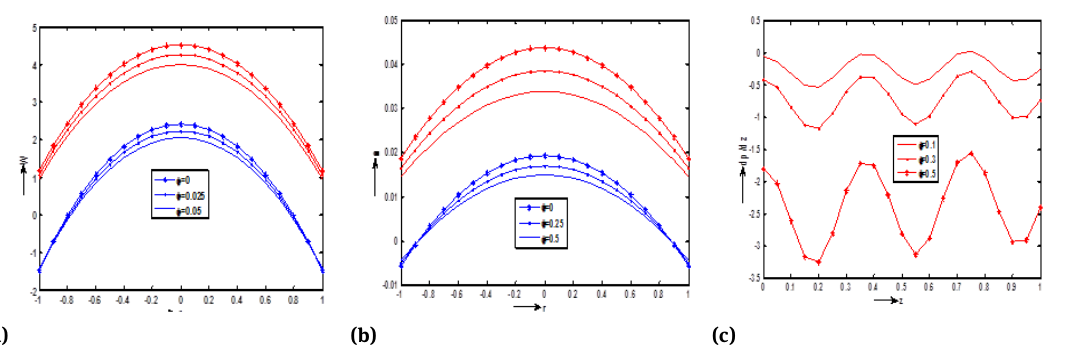
Fig. 2: (a) Velocity profile for various values of ϕ (b) Temperature profile for various values of ϕ (c) Pressure gradient for various values of ϕ